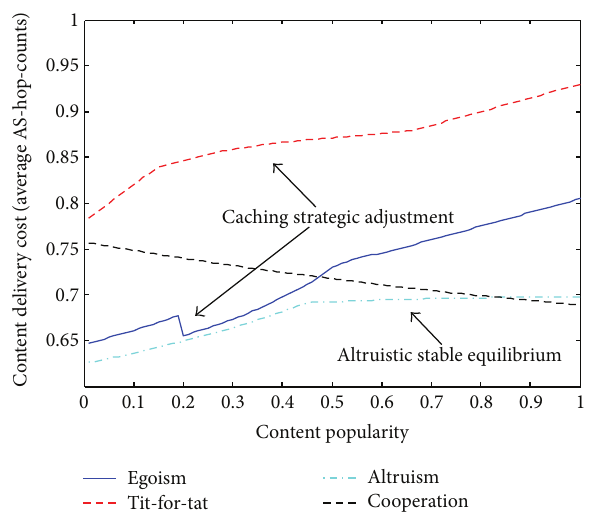
Figure 5: Content delivery cost versus content popularity.